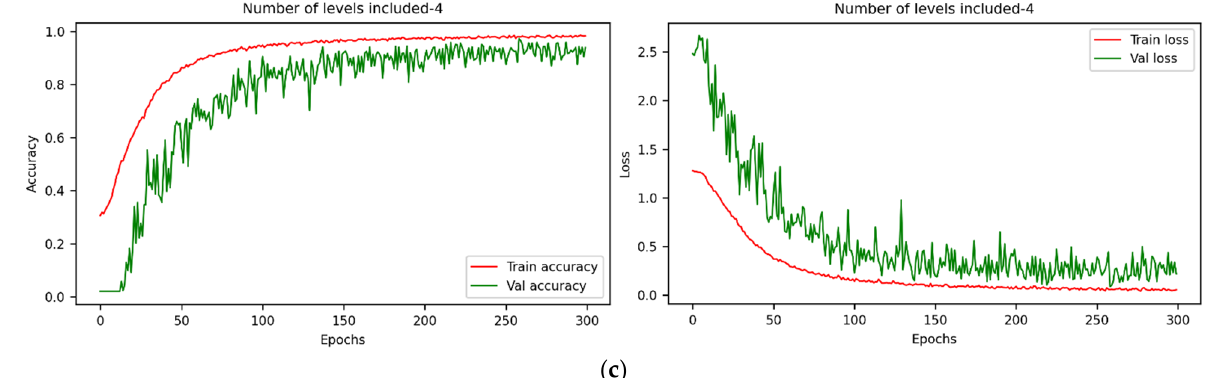
Figure 7. Training process of the DCNN model. ( a ) Iterative curves of training set and validation set for two vitality levels; ( b ) iterative curves of training set and validation set for three vitality levels; ( c ) iterative curves of training set and validation set for four vitality levels.